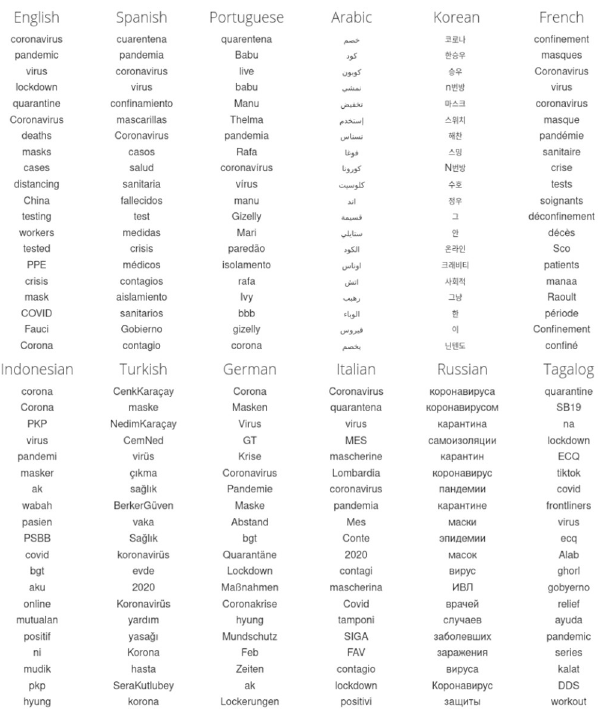
Fig 2. Top 20 (of 1,000) 1-grams for our top 12 languages for the first three weeks of April 2020 relative to a year earlier. Our intent is to capture 1-grams that are topically and culturally important during the COVID-19 pandemic. While overall, we see pandemic-related words dominate the lists across languages, we also find considerable specific variation. Words for virus, quarantine, protective equipment, and testing show different orderings (note that we do not employ stemming). Unrelated 1-grams but important to the time of April 2020 are in evidence; the balance of these are important for our understanding of how much the pandemic is being talked about. To generate these lists we use the allotaxonometric method of rank-turbulence divergence to find the most distinguishing 1-grams (see Sec. Selection of languages and n-grams, Fig 1, and Dodds et al.